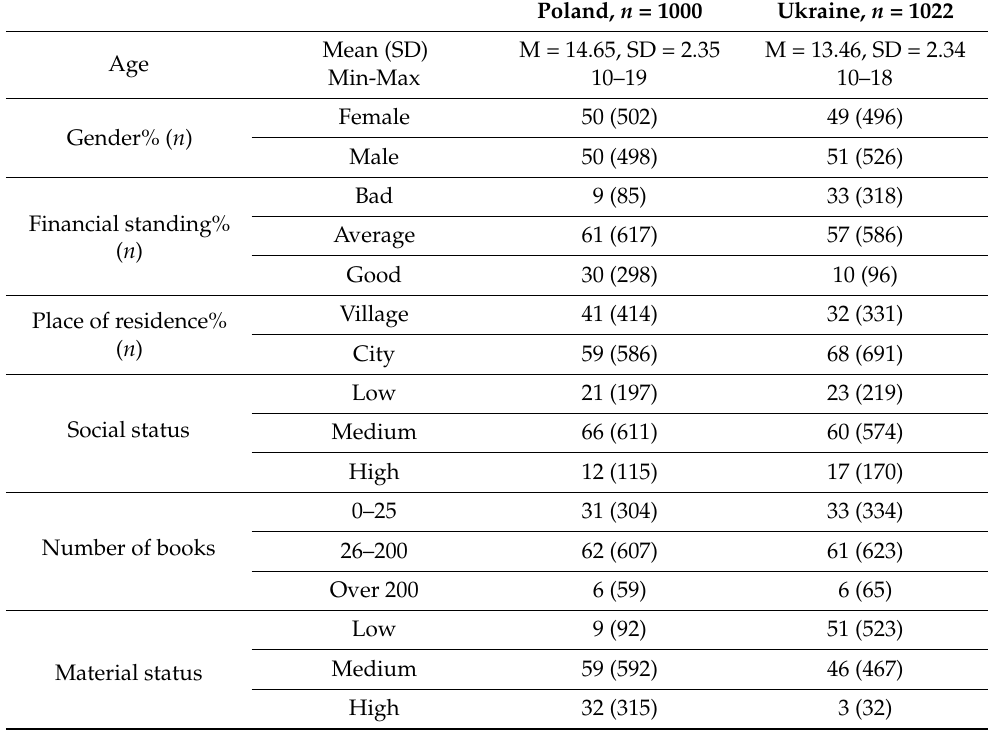
Table 1. Socio-demographic characteristics of